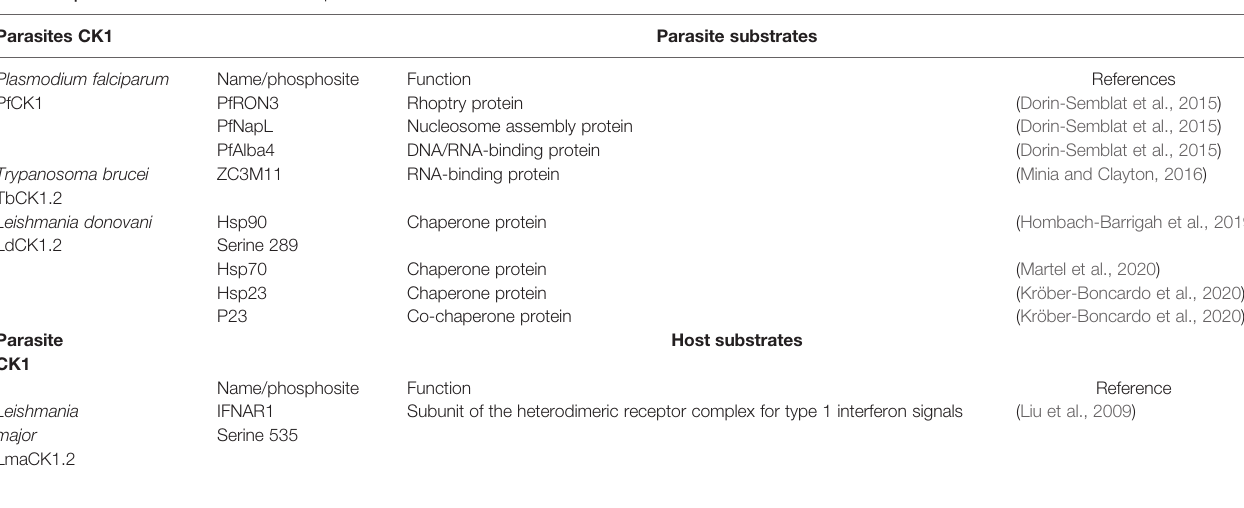
TABLE 2 | Parasite and host substrates of parasitic